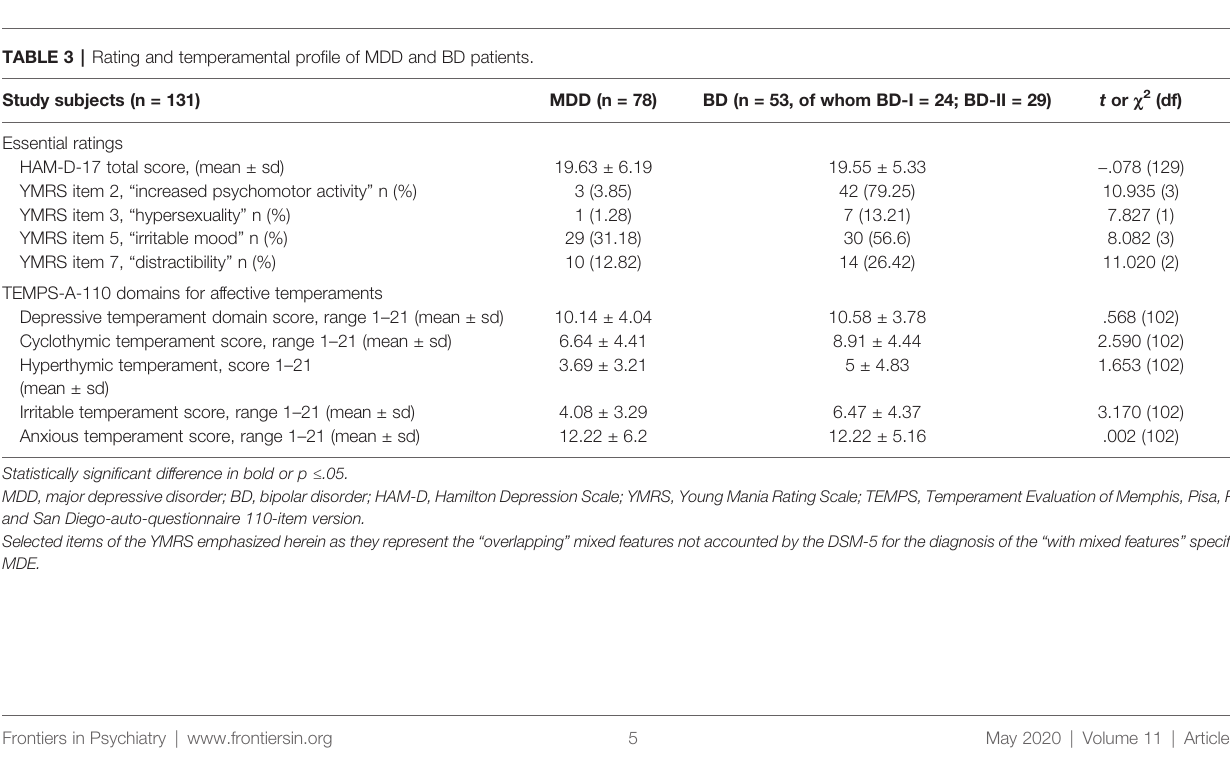
TABLE 2 | Essential pharmacological treatment history across the included cases. Data expressed as “ n (%) ” Currently on antidepressant(s)